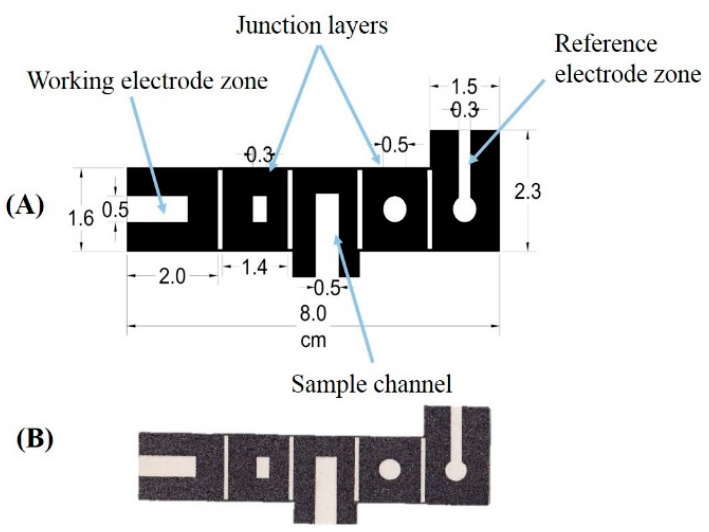
Figure 1. ( A ) Schematic diagram for fabrication of origami potentiometric device pattern. ( B ) The image of fabricated origami potentiometric device. The numbers denote the sizes in cm.